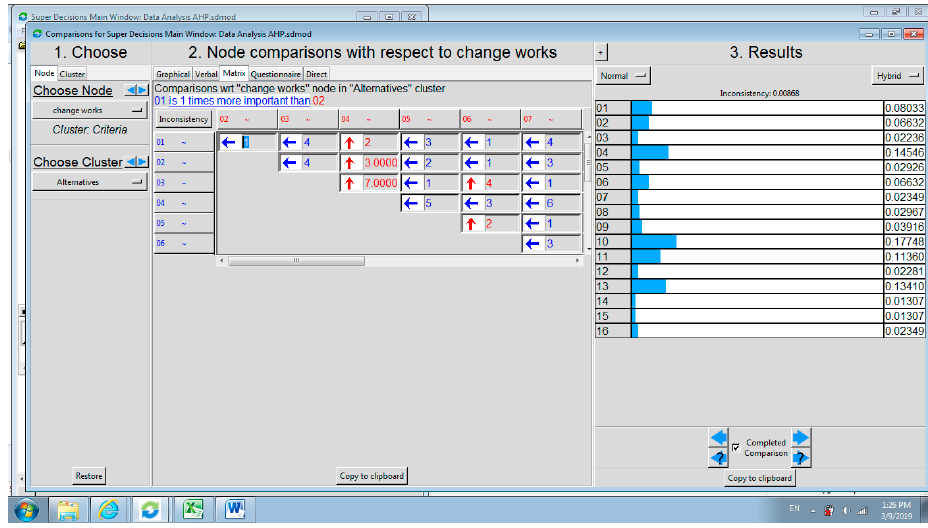
Figure 2. SuperDecision software